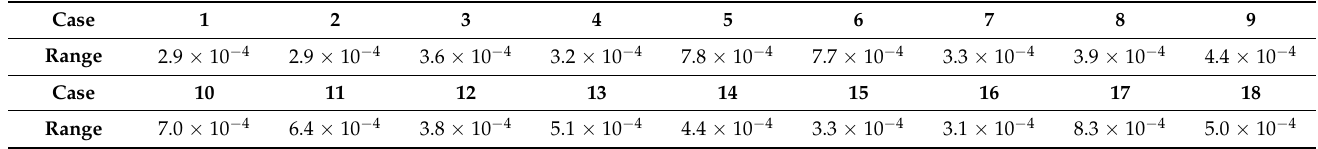
Table 4. The range of inequality indicators under cases